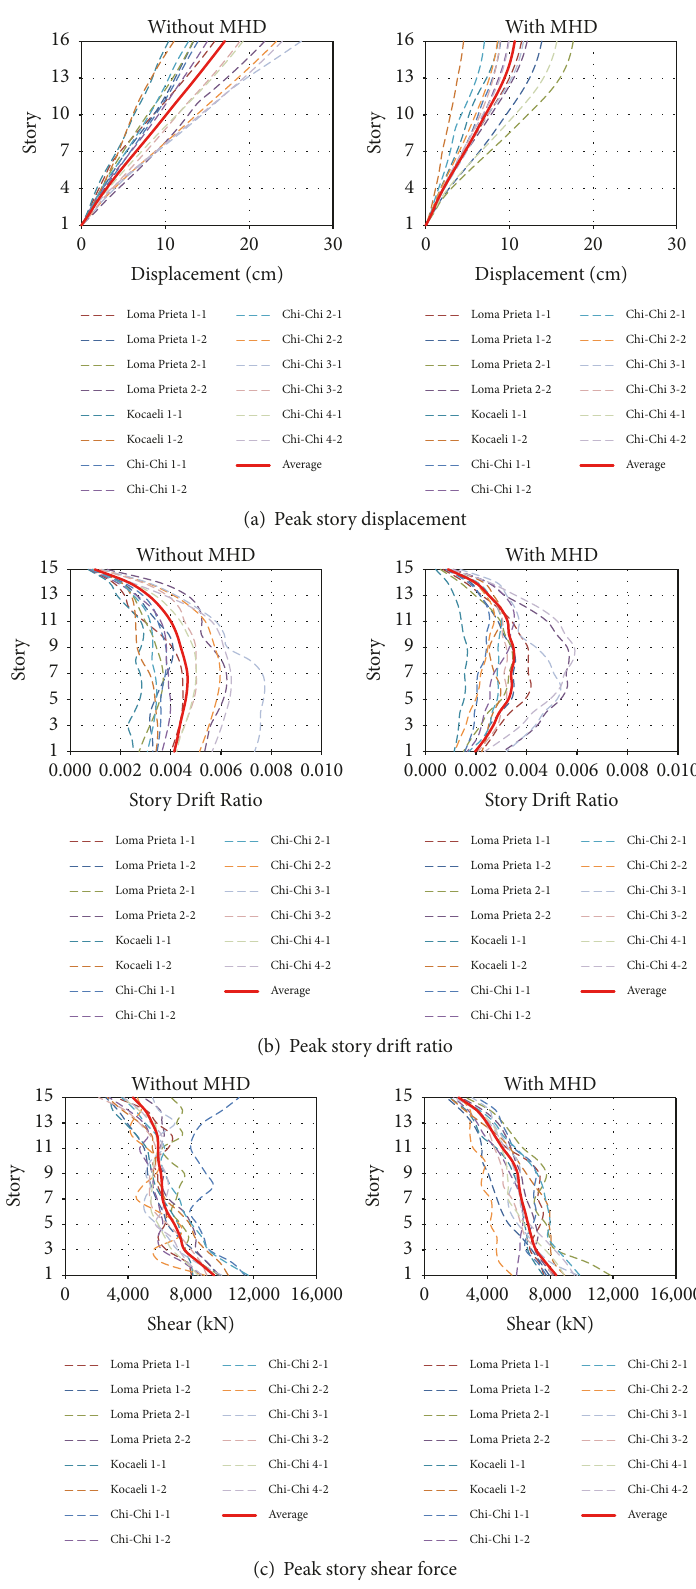
Figure 23: Response comparison between structures with/without